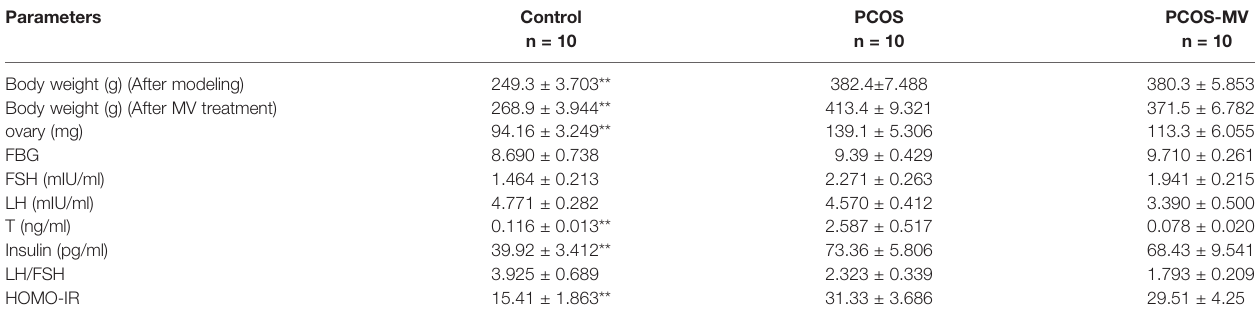
TABLE 2 | Measurements of body weight, ovary weight and hormone concentrations in Control, PCOS and PCOS-MV groups. Parameters